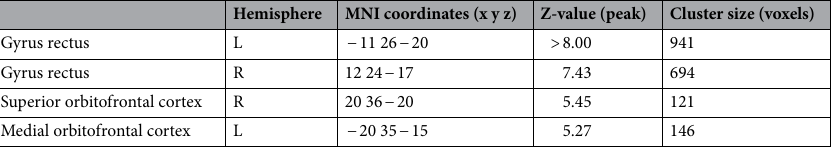
Table 2. Significant clusters from the F-test for a main effect of etiology of olfactory loss. All regions are reported at p < 0.05 (FWE) at cluster level.